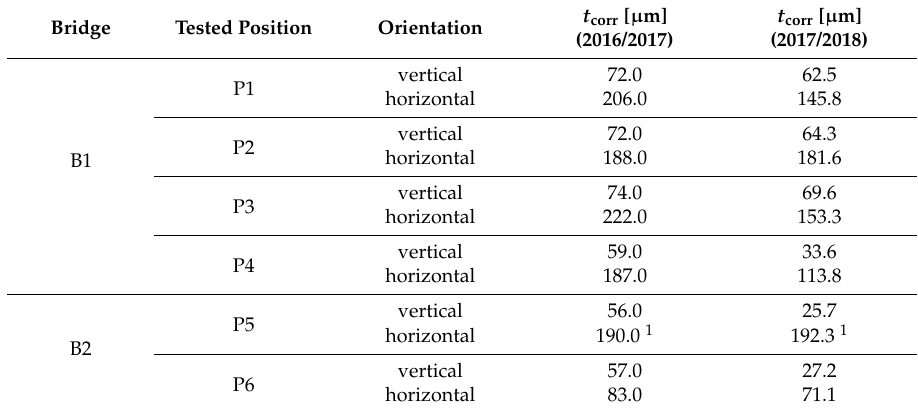
Table 3. Average thickness of corrosion products t corr after 1-year exposure [µm].